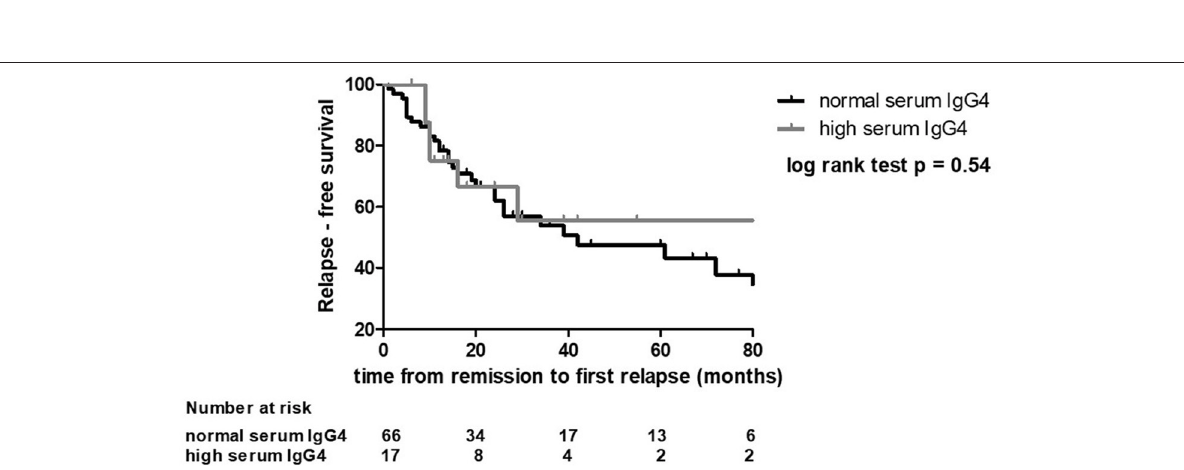
FIGURE 4 | Relapse-free survival in patients with high and normal serum IgG4 levels. Relapse-free survival was the time from remission to relapse or last follow-up.